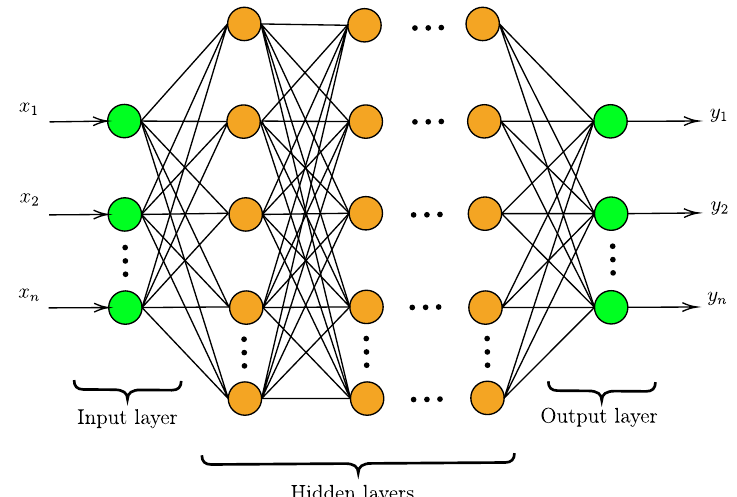
Fig. 17 DNN architecture proposed in